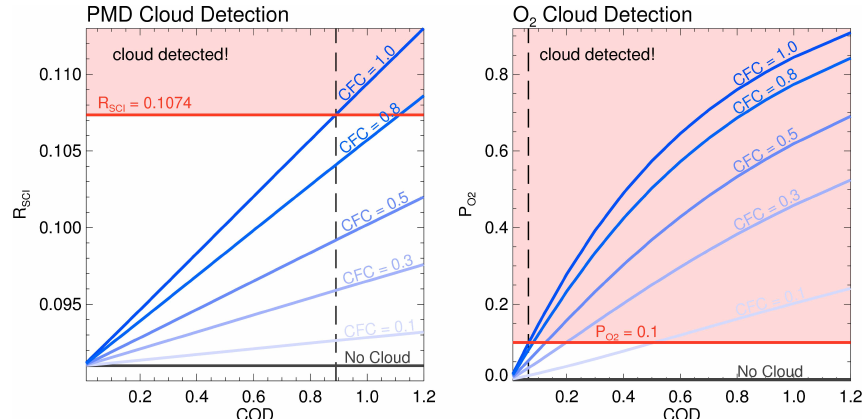
Fig. 2. PMD (given as reflectivity, left panel) and O 2 (right panel) cloud detection thresholds (red lines) compared to results obtained from radiative transfer simulations and simulated retrievals for various cloud scenarios. The left panel shows simulated reflectivity R SCI for the spectral region covered by PMD 1, as a function of cloud optical depth (COD) for different cloud fractional coverages (CFC). The results are valid for a surface albedo of 0.1, the default aerosol scenario, a cloud top height (CTH) of 10km and a cloud geometrical thickness (CGT) of 0.5km. The red line shows the PMD cloud detection criterion of R SCI =0.1074 and the black dashed line shows the minimum detectable COD for CFC=1.0. The panel on the right shows the simulated deviation of the retrieved O 2 -column to the a-priori O 2 -column, i.e. P O the same parameters as used for the left hand side. The red line shows the O 2 cloud detection threshold P O shows the minimum detectable COD for CFC=1.0.